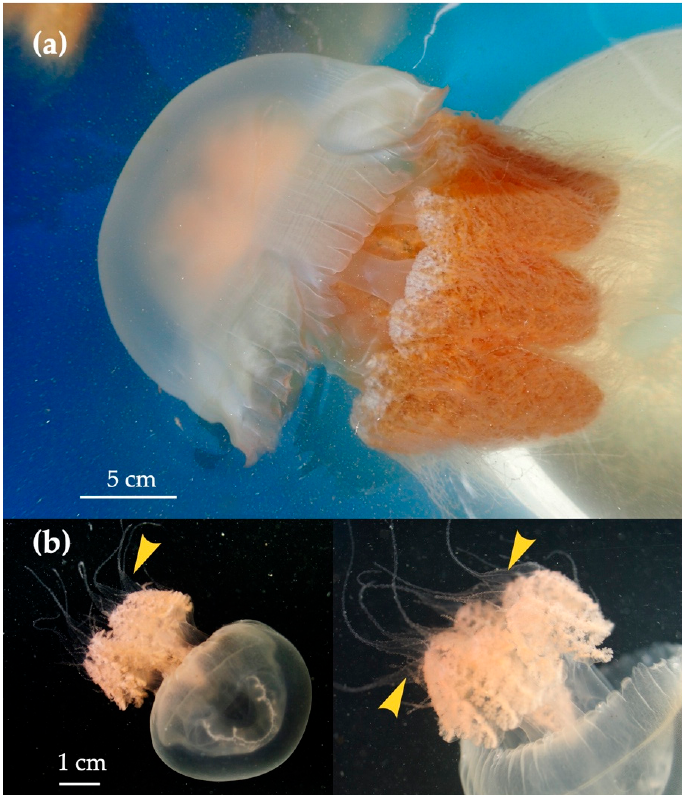
Figure 4. Acromitus hardenbergi Stiasny, 1934: ( a ) adult medusa; ( b ) appendage (arrow) . 3.3. Seasonal Difference in Size Distribution of A. hardenbergi Medusae in Perak River